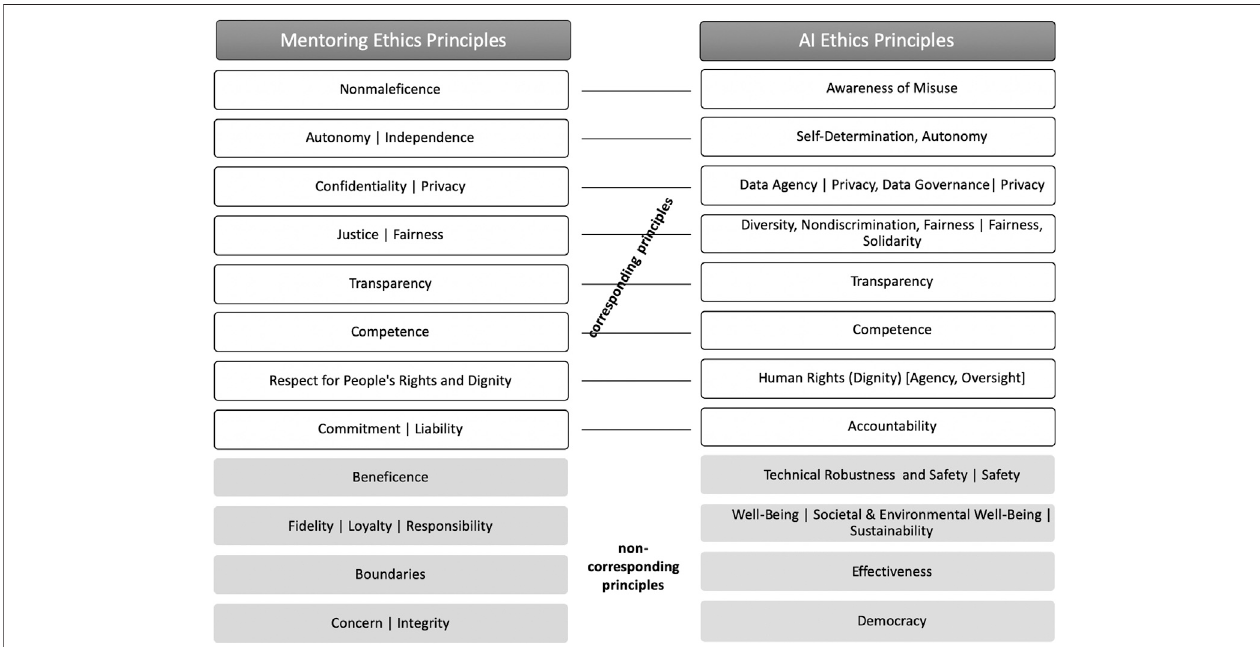
FIGURE 1 | Juxtaposition of corresponding and non-corresponding ethical principles in the contexts of mentoring versus